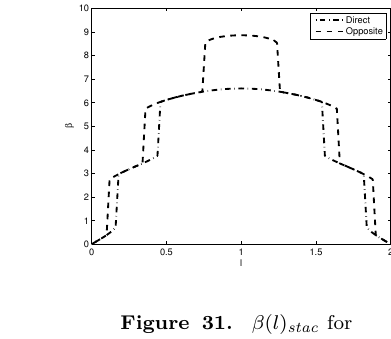
Figure 30. Droplets at ωτ = 0 ⇒ 10 ⇒ 12 ∪ 12 ⇒ 10, t f = 6.